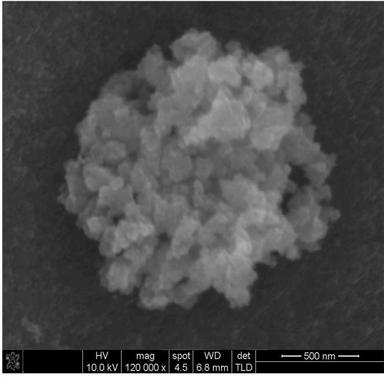
FE-SEM micrograph of TiO2–C,N powder photocatalyst.